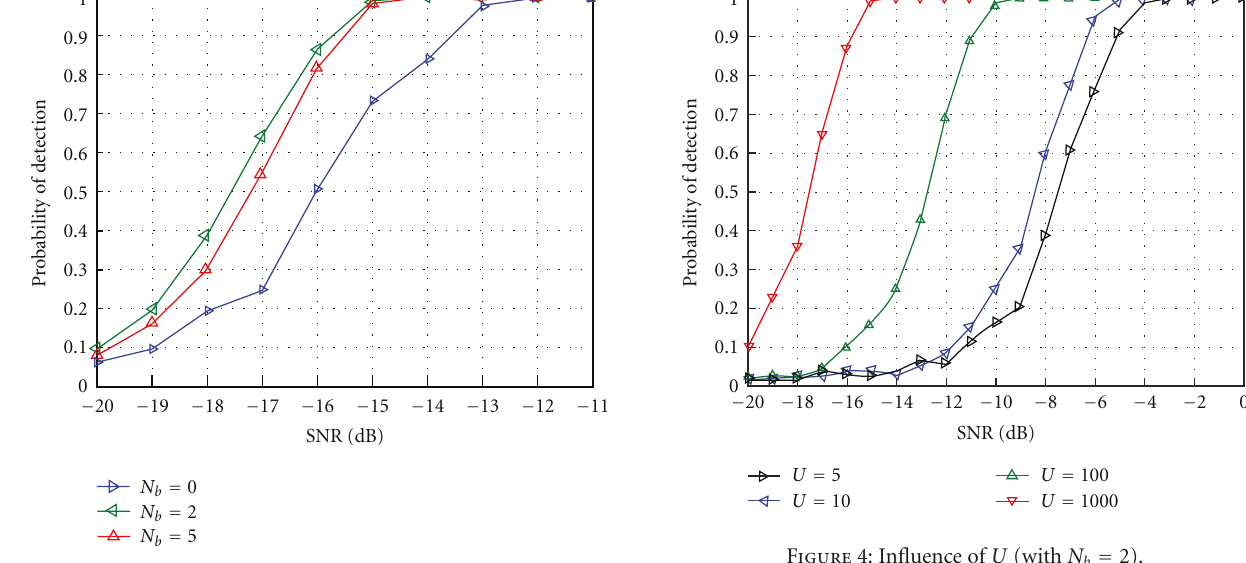
Figure 3: Influence of N b .